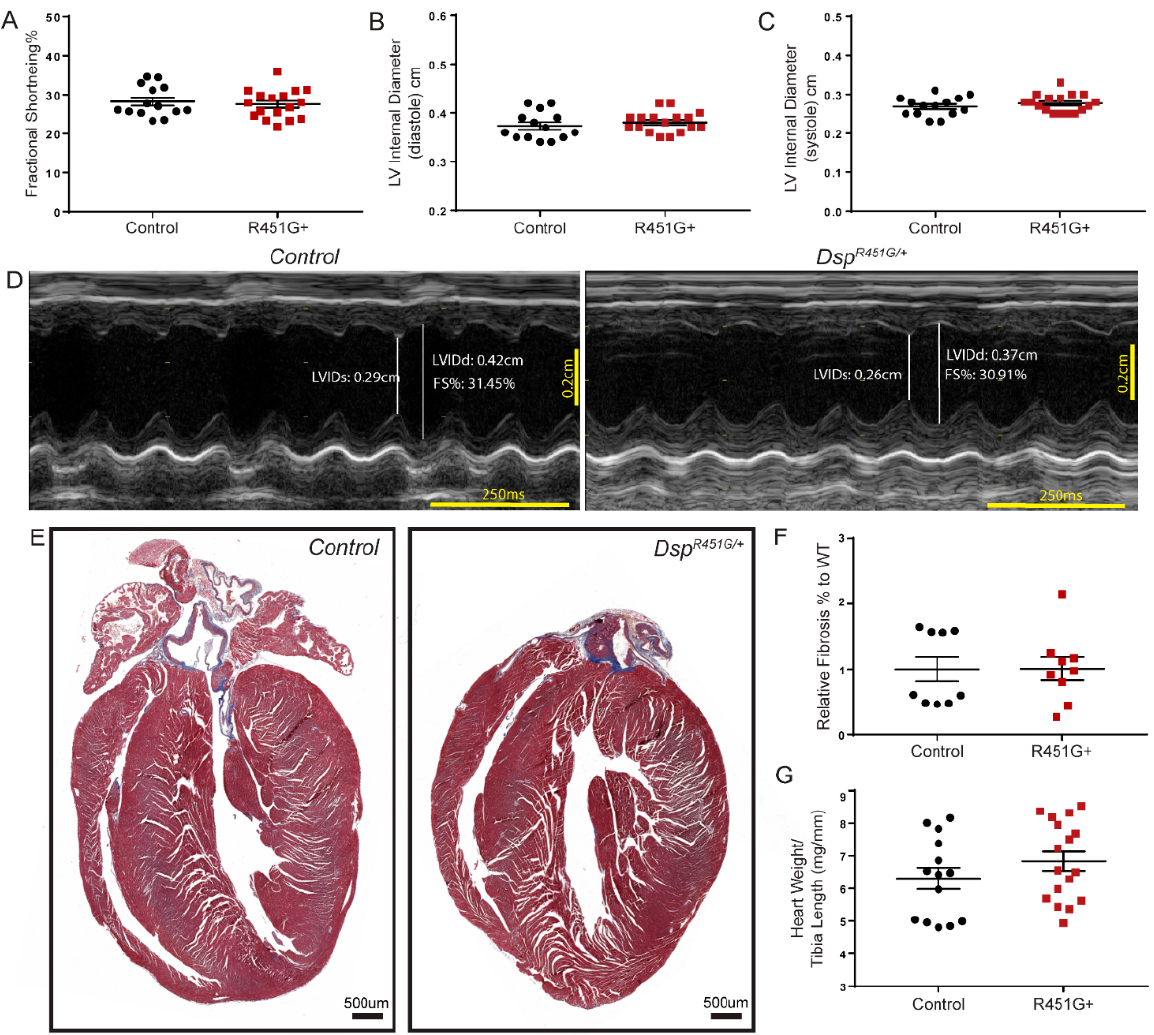
Figure 3. Dsp R451G/+ mice display no structural changes at baseline. ( A ) Baseline echocardiography measurements conducted on 6-month control and Dsp R451G/+ mice and littermates comparing frac- tional shortening, ( B ) LVIDd, ( C ) and LVIDs (control n = 14, Dsp R451G/+ n = 17). ( D ) Representative M-mode echocardiography recordings from control and Dsp R451G/+ mice performed at 6 months. ( E ) Masson’s trichrome staining performed on 6 month old control and DSP R451G/+ mice littermates. ( F ) Relative fibrosis levels calculated from Masson’s trichrome staining ( n = 9 per genotype). ( G ) Heart weight to tibia length ratio isolated following echocardiography experiments (control n = 14, Dsp R451G/+ n = 17) Stats performed using Student’s t-test.